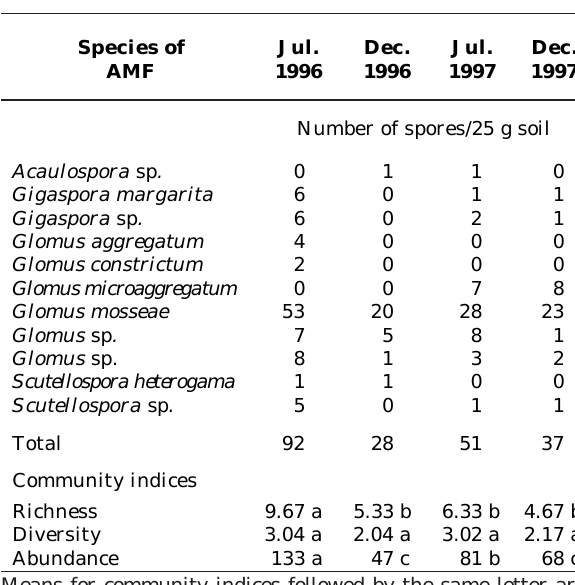
Table 6. Number of spores of AMF species recovered from field-collected soil of the Permanent Pasture. Species are listed in order of spore